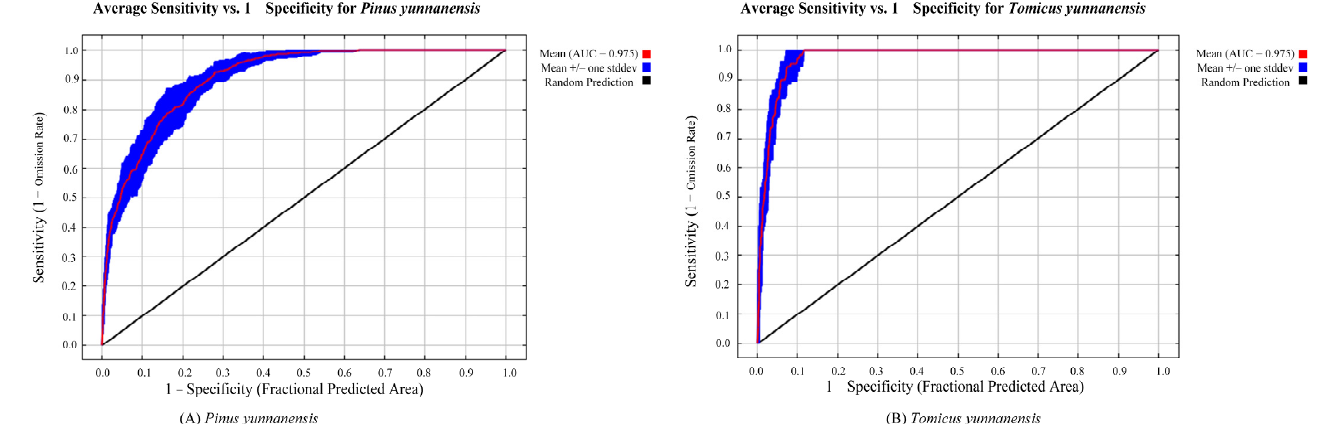
Figure 2. ROC curves and mean test AUC (10 replicate runs) of ( A ) P. yunnanensis and ( B ) T. yunnanensis.